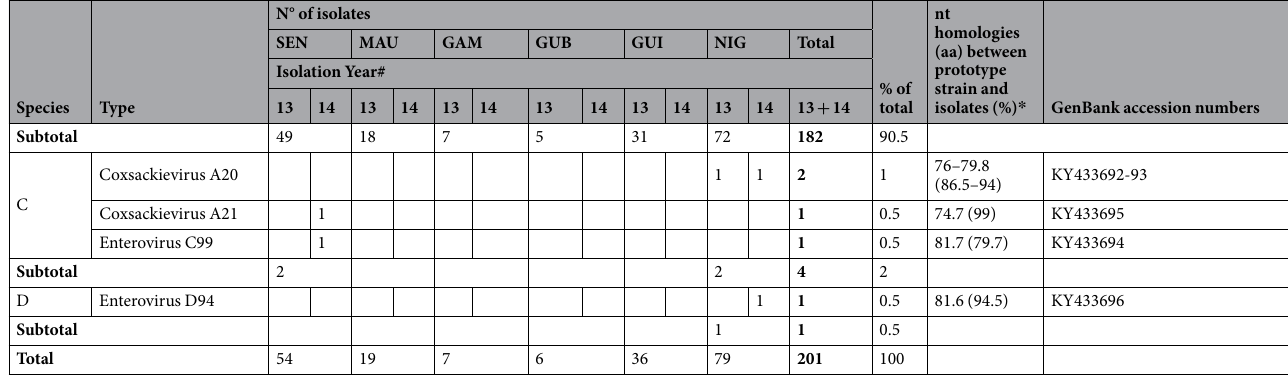
Table 2. Frequency of different enterovirus types detected in stool specimens of AFP cases, 2013-2014, based on partial VP1 gene sequences. SEN Senegal; MAU Mauritania; GAM Gambia; GUB Guinea Bissau; GUI Guinea Conakry; NIG Niger. * Homology was calculated using the ~400 bp length of the 5 ′ end of VP1. # Year code: 13 for 2013; 14 for